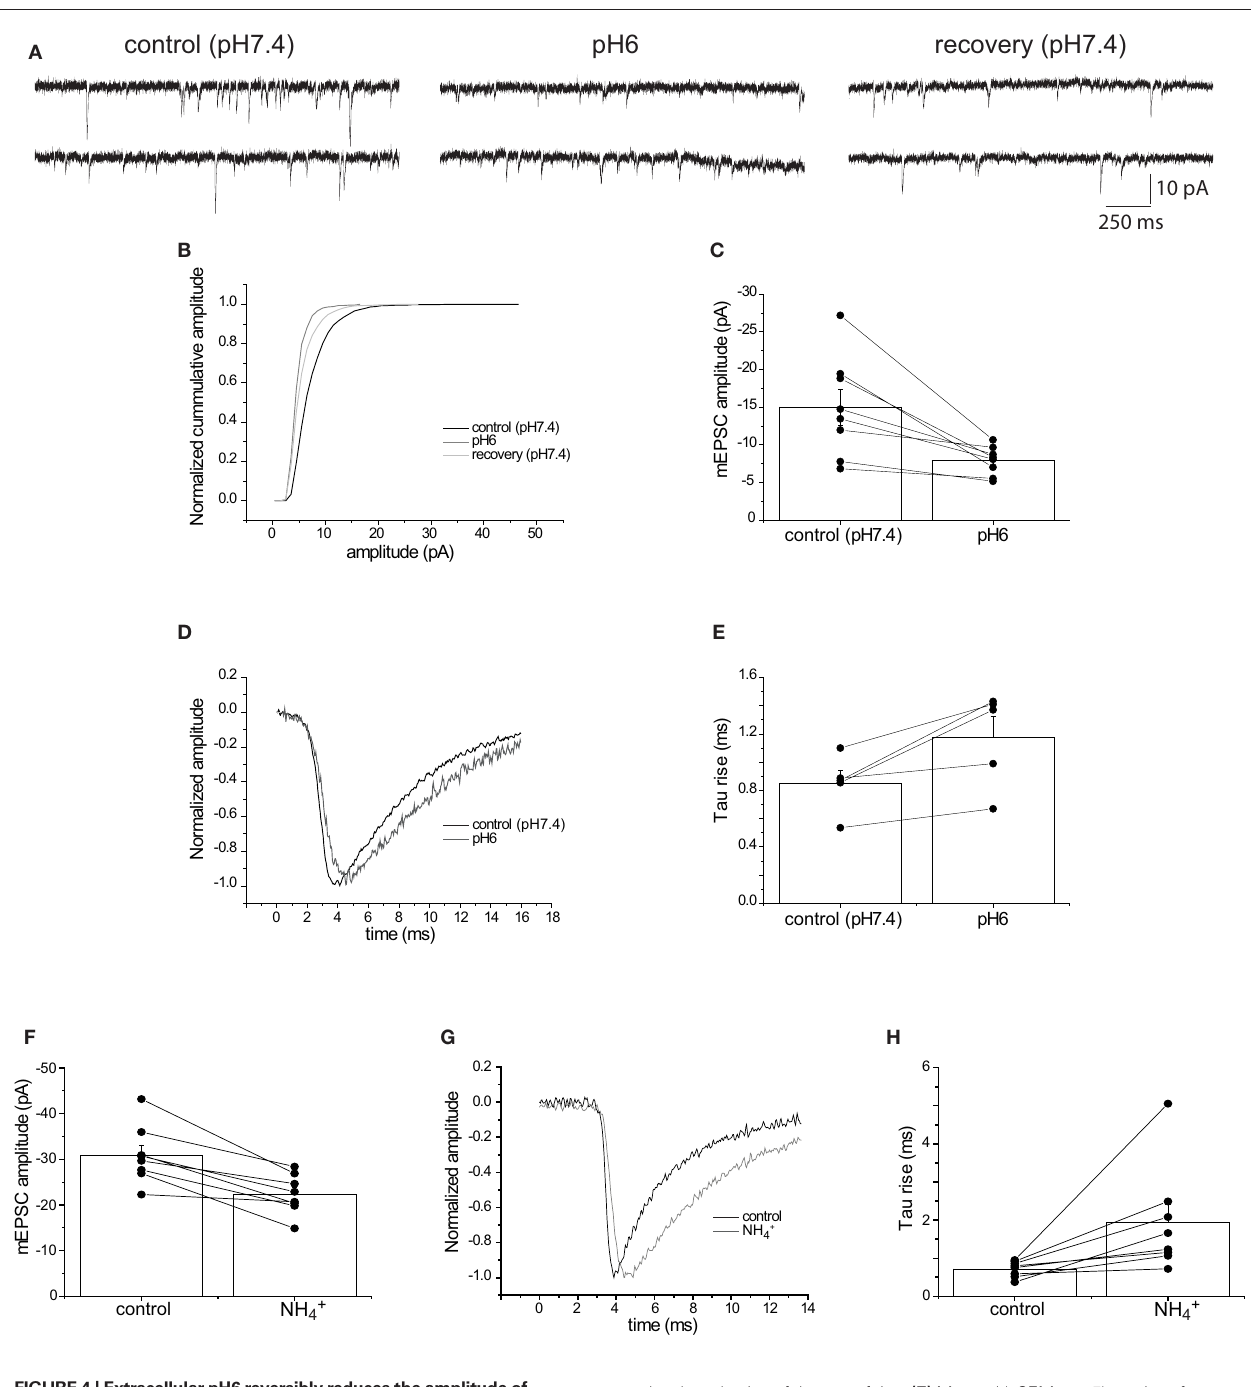
the clear slowing of the rate of rise. (e) Meaned ( ± SEM, n = 5) tau rise of mEPSCs before and in the presence of pH6 solution, with time-courses from individual cells shown as an associated line series plot. (F) Meaned ( ± sem , n = 8) mEPSC amplitude before and after addition of extracellular NH Cl (30 mM). 4 Amplitudes from individual cells are shown in a combined line series plot. (g) Normalized mEPSC waveforms from a cell before and after the extracellular addition of NH Cl (30 mM), showing the clear slowing of the rate of rise. 4 (H) Meaned ( ± sem , n = 8) tau rise of mEPSCs before and after the extracellular addition of NH Cl (30 mM), with time-courses from individual cells shown as an 4 associated line series